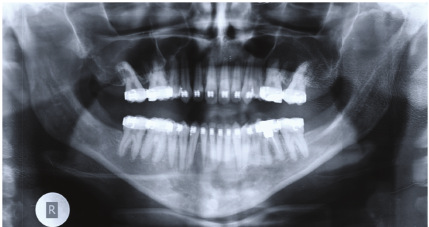
Figure 12: Presurgical orthopantomogram (OPG).